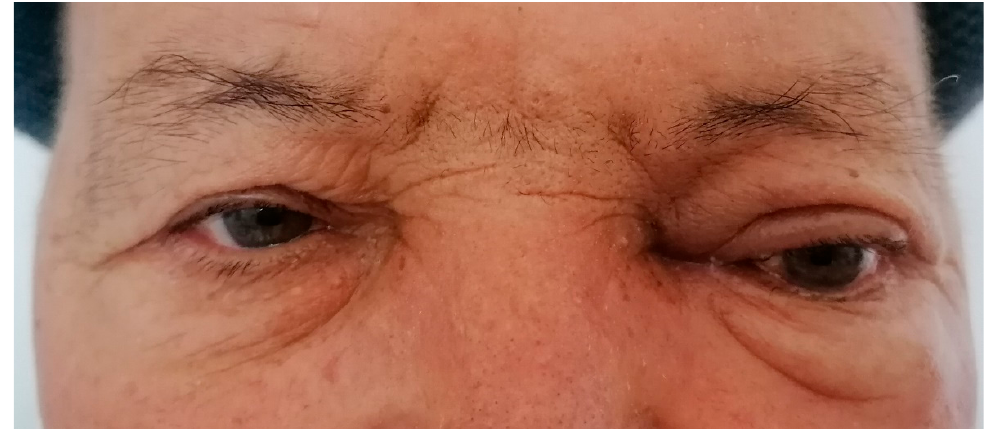
Figure 5. Left eye at one-month follow-up after treatment with maximal topical anti-glaucoma eye drops (topical beta-blockers, alpha-agonists, and carbonic anhydrase inhibitors) followed by radiotherapy sessions. We noticed a slight improvement in the symptomatology, with the disappearance of diplopia and normalization of intraocular pressure. Breast cancer in men (MBC)